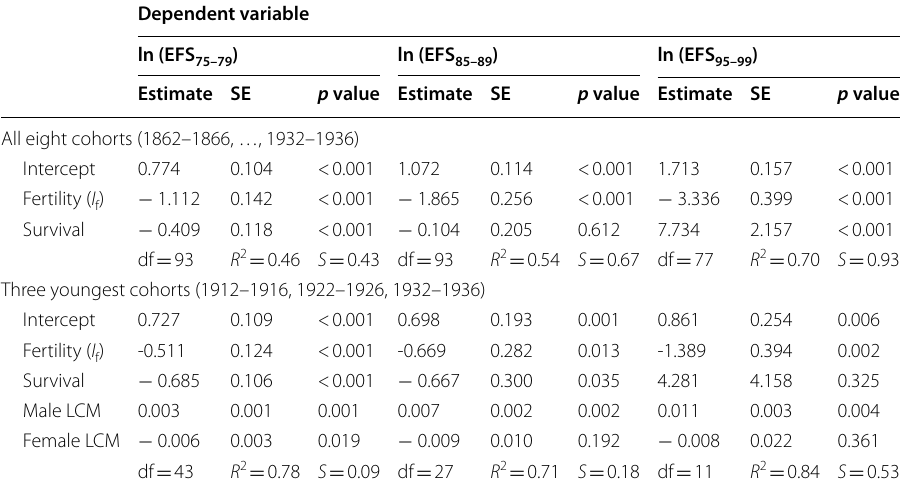
Table 4 Checks on the relation between fertility and excess female survival at various old